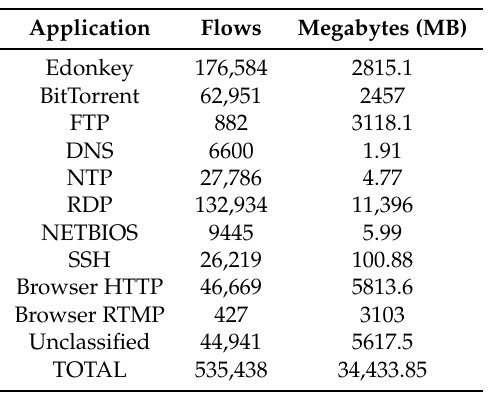
Table 1. CATALUNYA2013 dataset